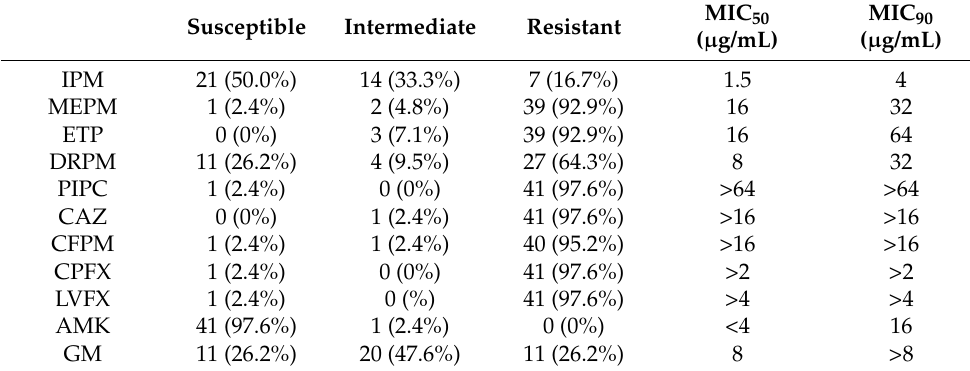
Table 1. Antimicrobial susceptibility among 42 strains of IMP-6-producing E. coli .